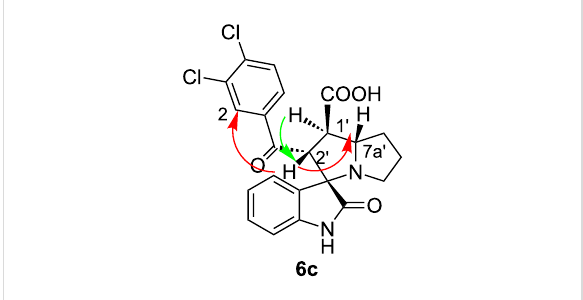
Figure 3: The NOE correlations of the signals in 1 H NMR spectrum of compound 6c .